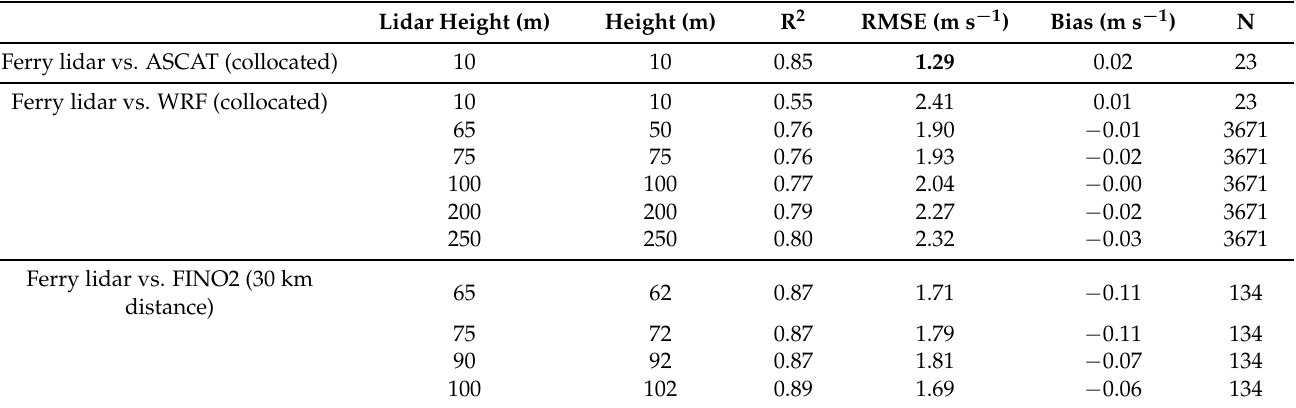
Table 3. Ferry lidar statistical characteristics (bias, RMSE, correlation) of wind speed with ASCAT, WRF, and FINO2. Lidar Height (m)